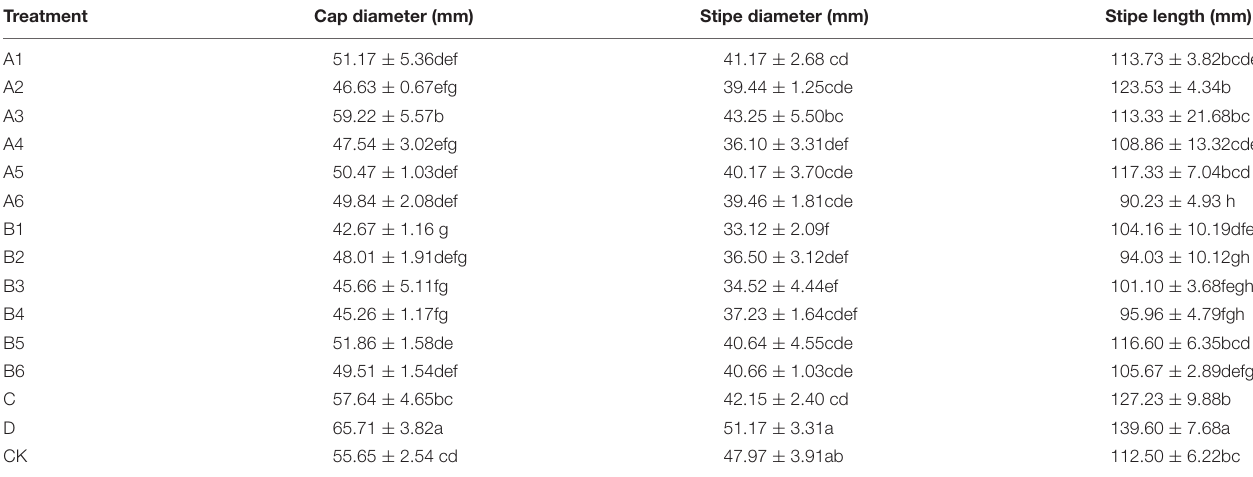
TABLE 3 | Effects of different treatments on agronomic characters of fruiting bodies. Treatment